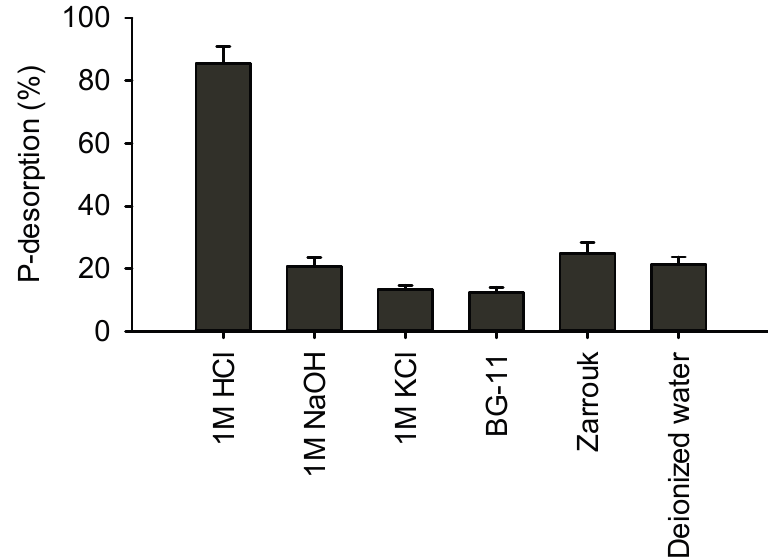
Figure 1. Desorption of P from P-loaded zeolite using various desorption solutions. P-loaded zeolite concentration 2.5 g/L, desorption duration 24